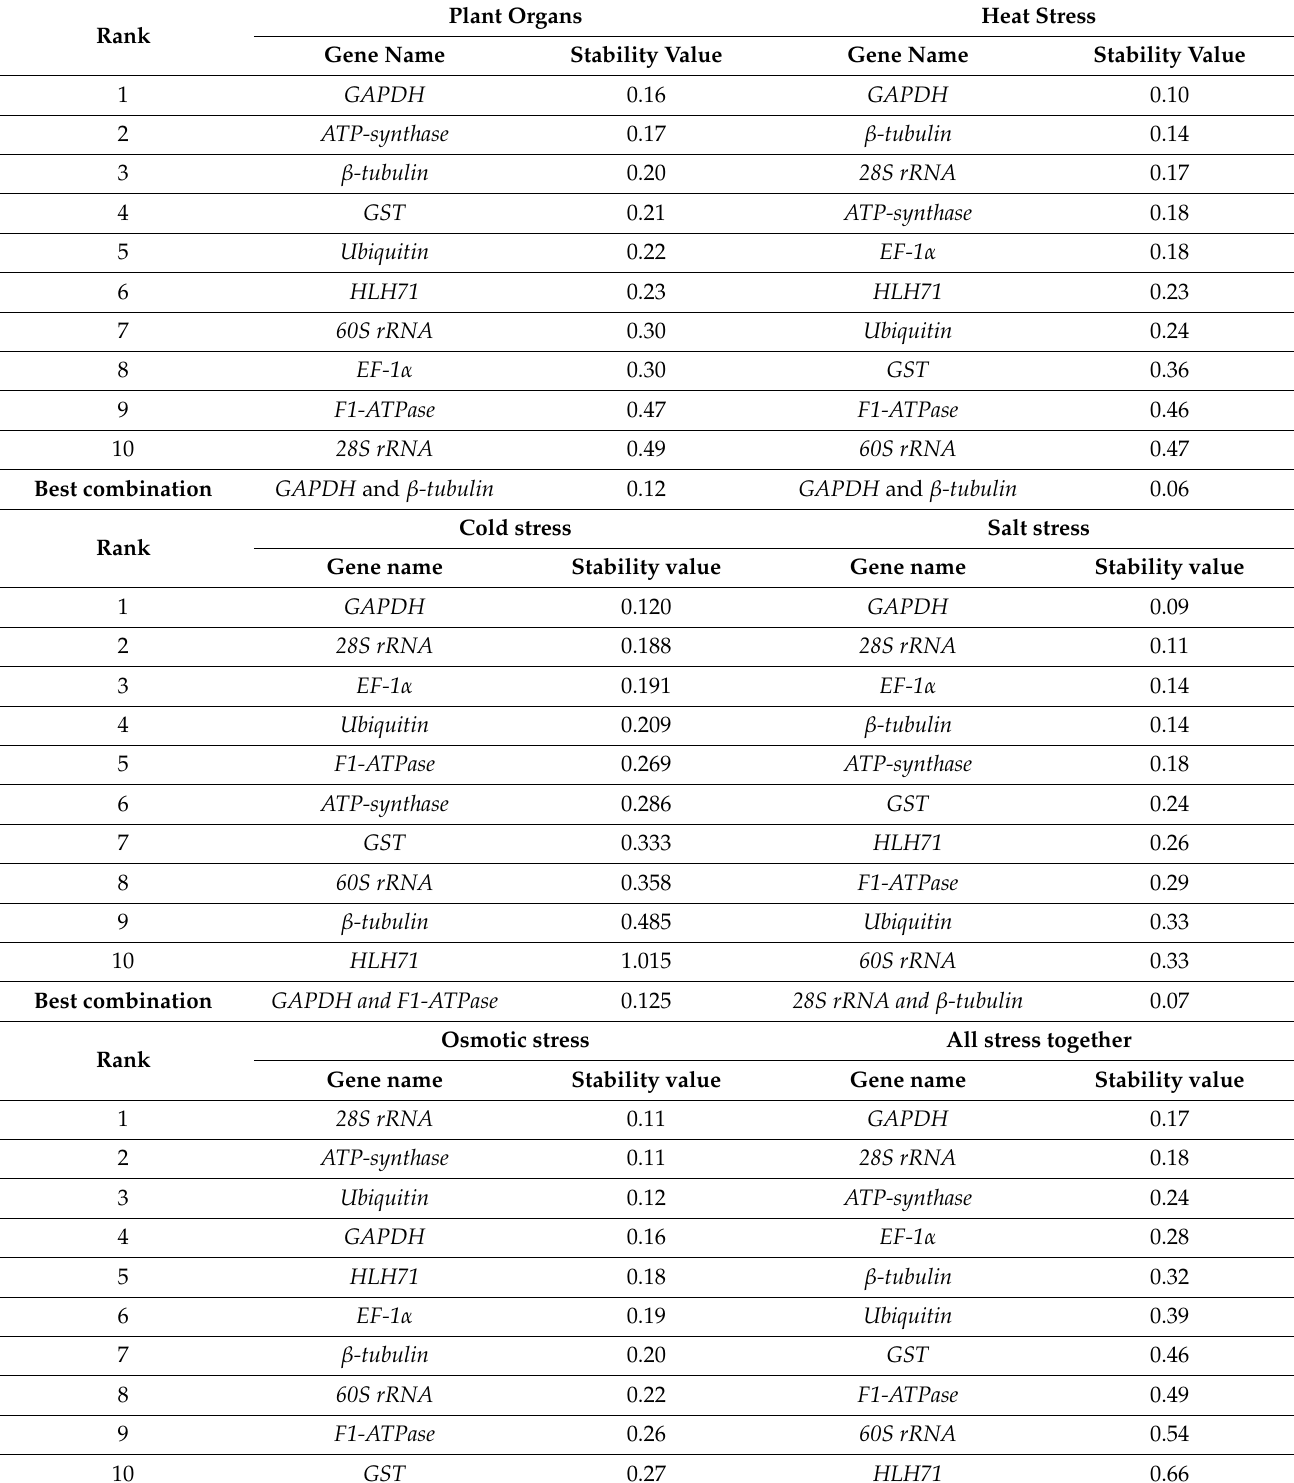
Table 3. Expression stability of candidate genes analyzed by